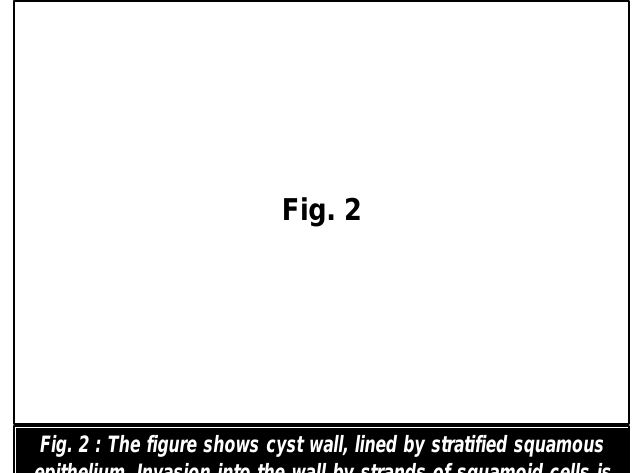
Fig. 2 : The figure shows cyst wall, lined by stratified squamous epithelium. Invasion into the wall by strands of squamoid cells is also shown. Hematoxylin & Eosin stain. Magnification x